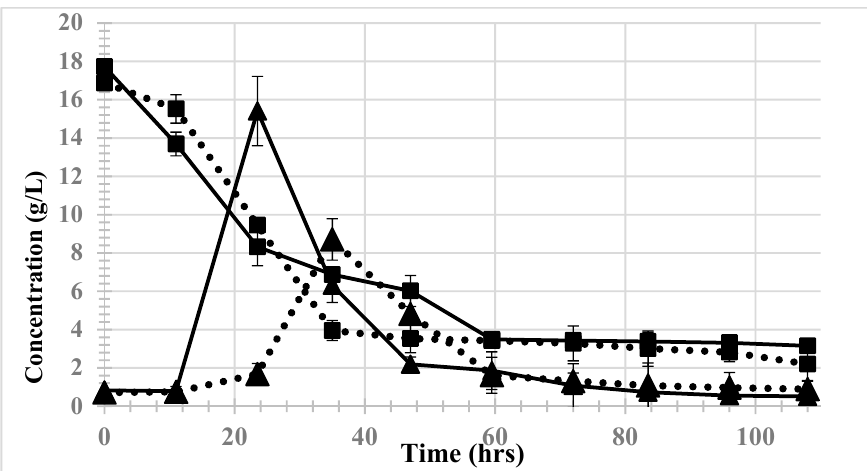
Figure 4. Total sugars ( ν ) consumed and ethanol ( Δ ) produced during fermentation of the vetiver hydrolysates. Solid lines represent the experimental group and dashed lines represent the control group. Error bars show standard deviation with n = 6.